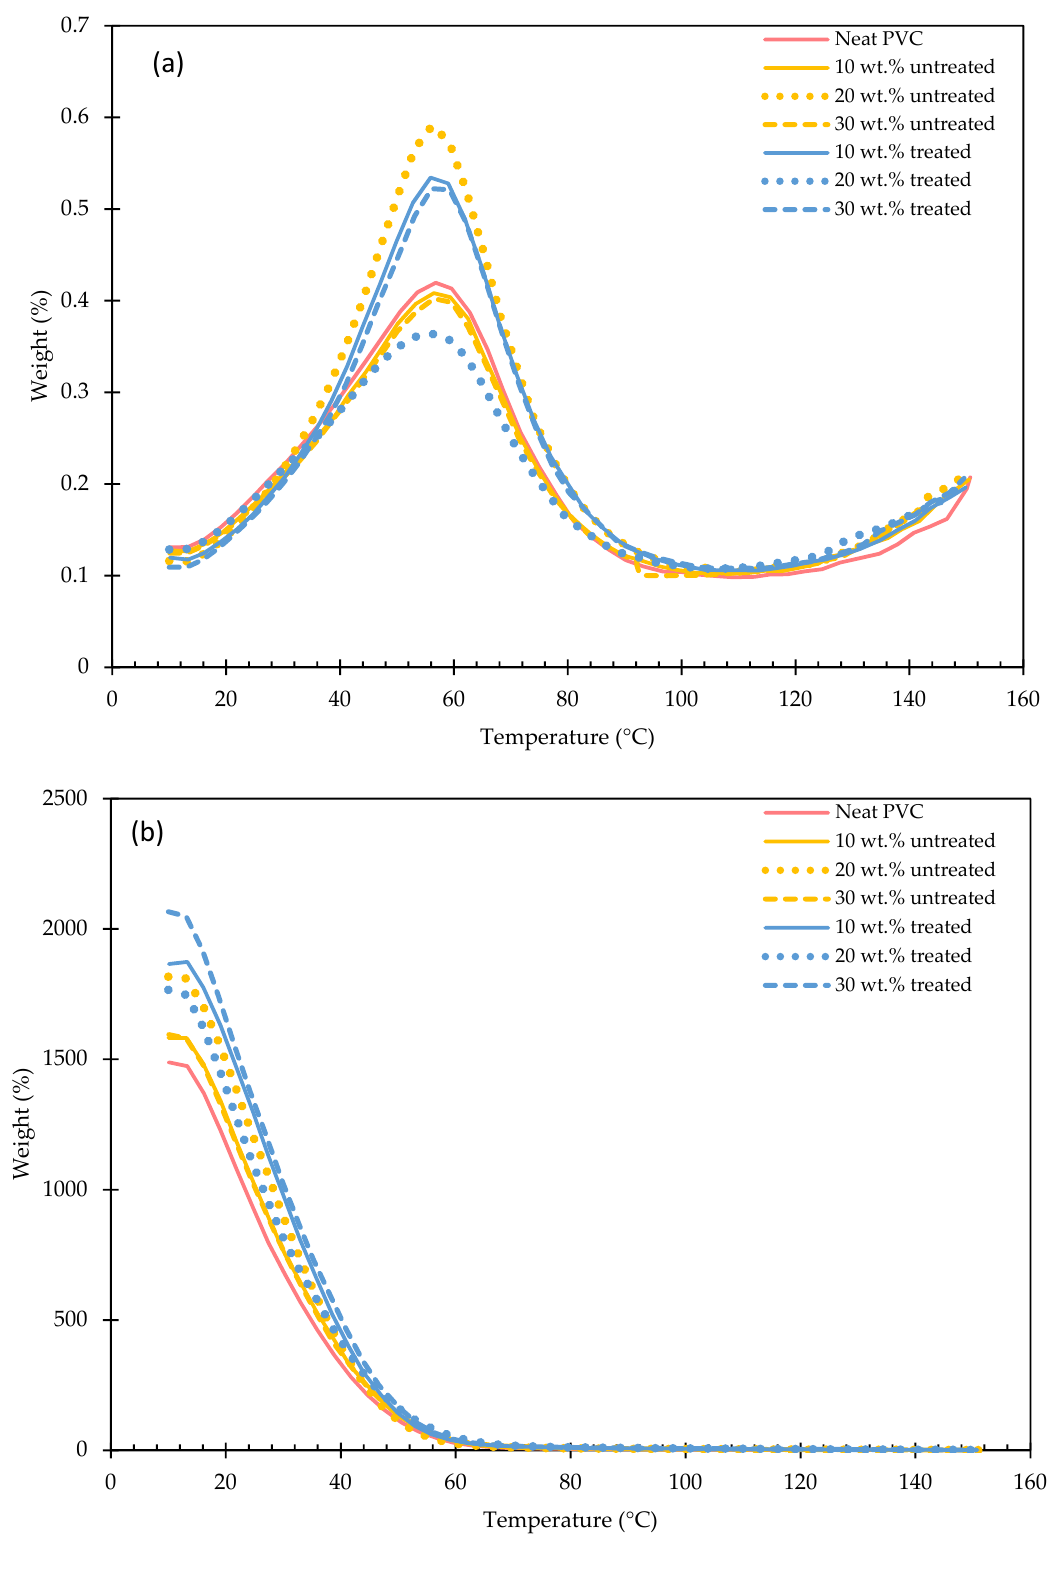
Figure 9. DMA of untreated and treated NMPCB/PVC composites: ( a ) storage modulus and ( b ) tan δ . For the treated NMPCB/PVC composites, the obtained storage modulus (E (cid:48) ) was higher than that of the untreated PVC composites. This result is due to the stronger In Figure 9a, the increase in the storage modulus (E ′ ) at the glassy region (room temperature) occurred with an increase in the amount of untreated NMPCB loading of 10,